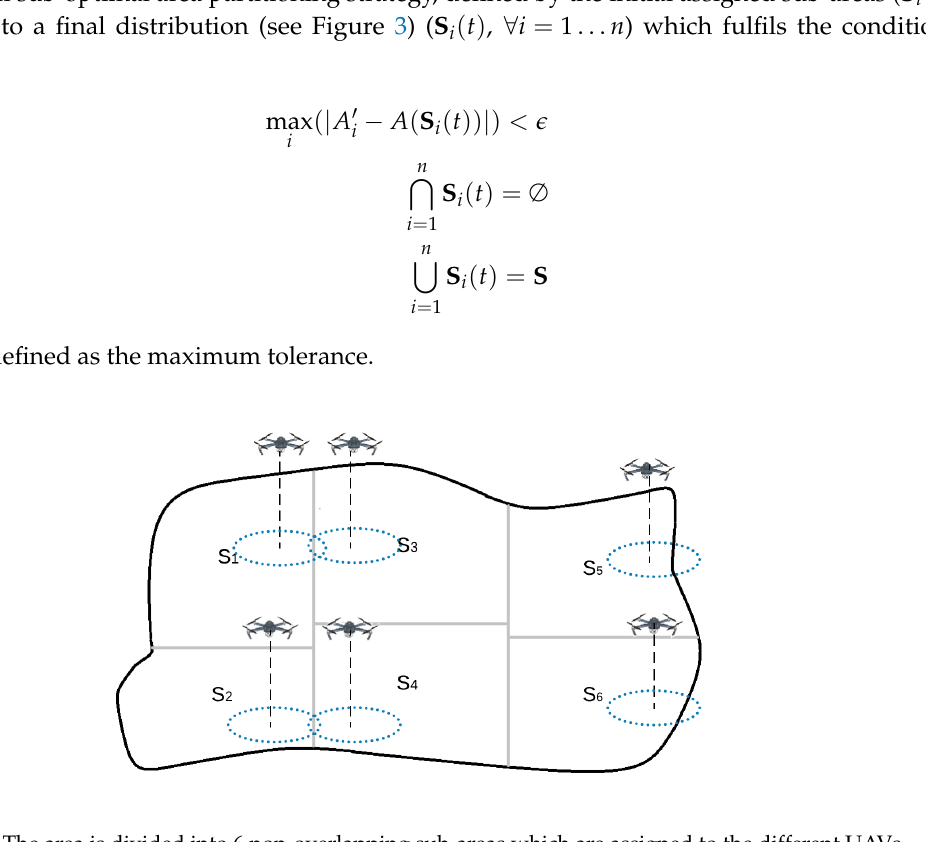
Figure 3. The area is divided into 6 non-overlapping sub-areas which are assigned to the different